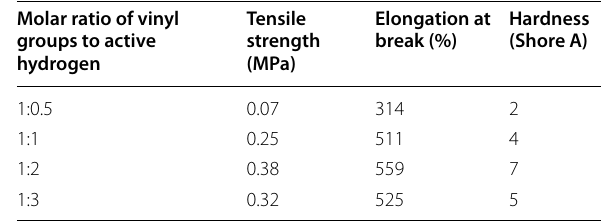
Table 3 Effect of Vi PDMS Vi mixture with different viscosity on mechanical properties of PDMS polymer film